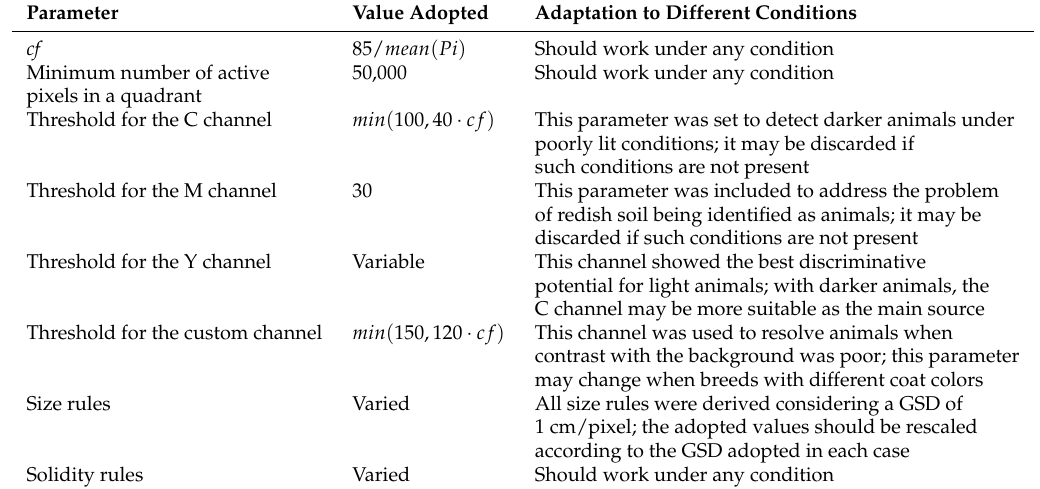
Table 1. Tunable parameters used in this